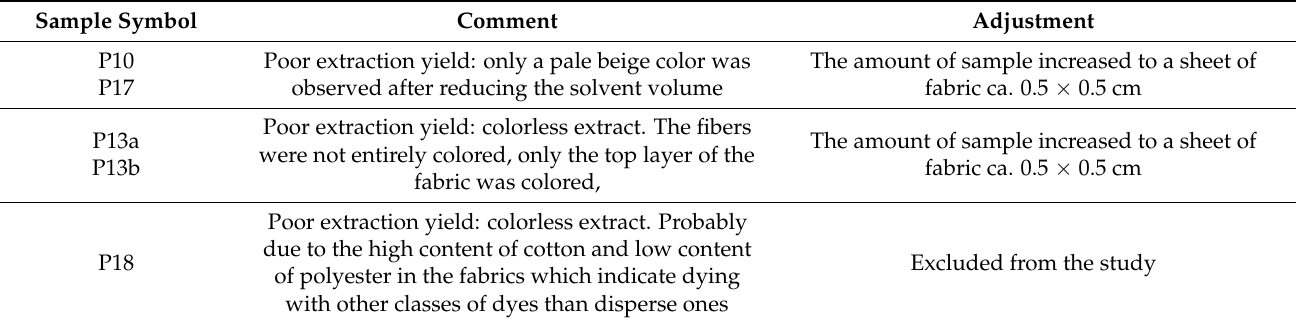
Table 8. Modifications of extraction procedure for samples P10, P13a, P13b, P17,